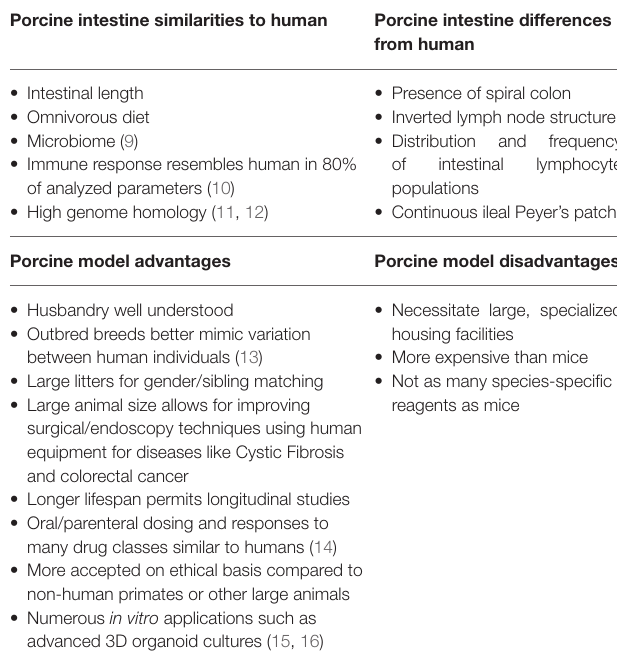
TABLE 1 | Summary of comparisons between human and porcine intestinal physiology and anatomy as well as advantages and disadvantages of porcine